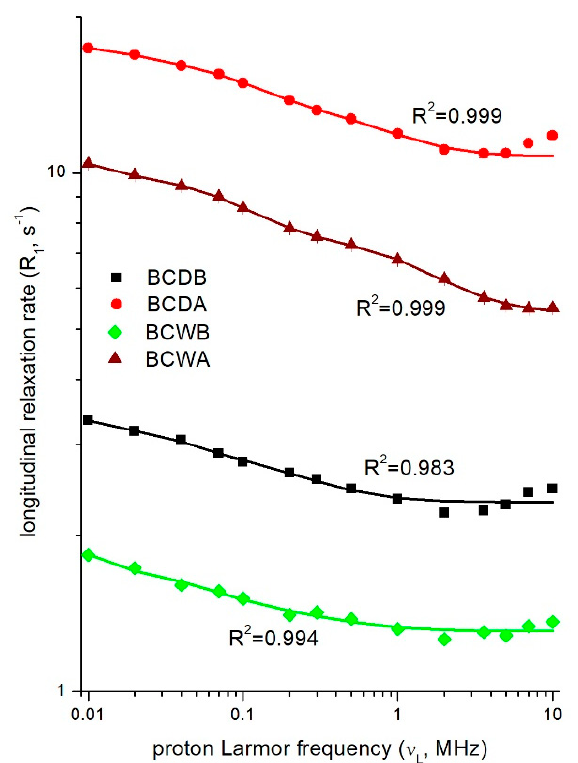
Figure 6. NMRD profiles of the four biochars studied here. The continuous lines were obtained by fitting the experimental data with the heuristic algorithm. In the legend, BC stands for biochar, D and W stand for dry − quench and wet − quench, respectively, B and A stand for before and after application to soil.